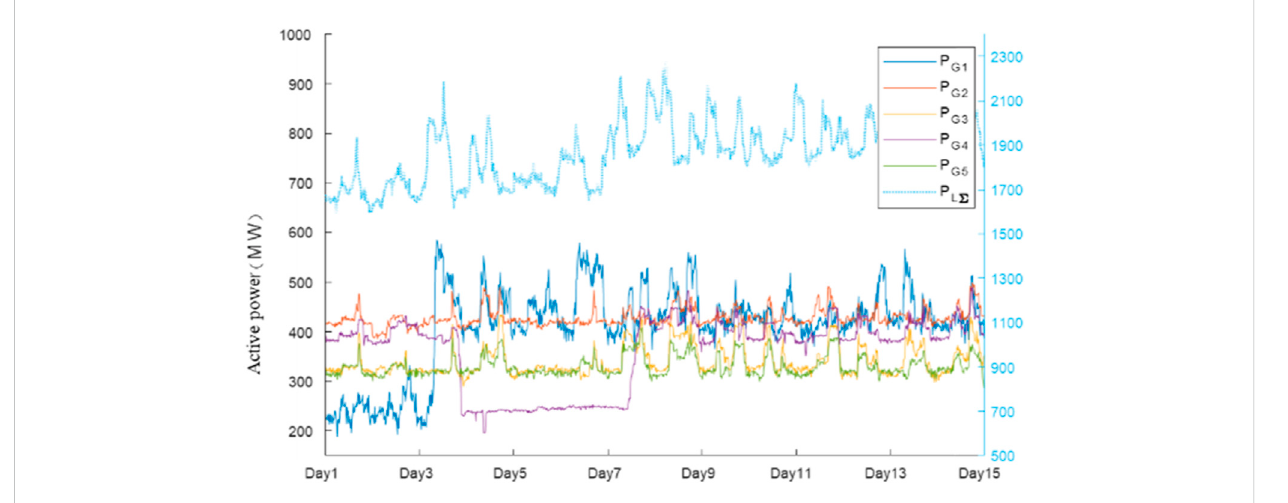
FIGURE 5 The measured total load and the power of each generator for 14